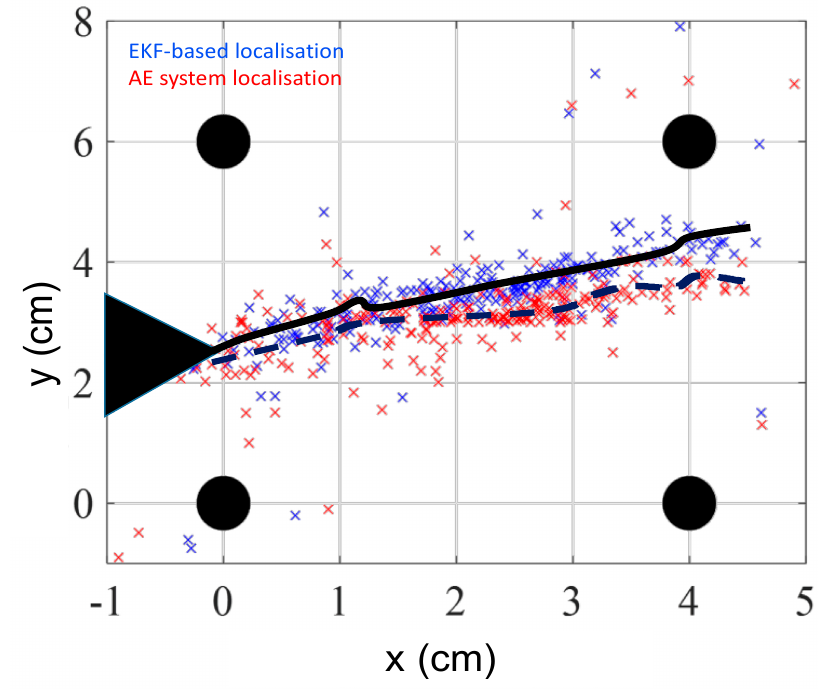
Figure 13. Comparison of the AE source localizations performed with the AE system and the EKF method during the mechanical test. The path of the crack is obtained according to Figure 9c (solid). Approximate crack path is also plotted based on the AE system localization (dashed).